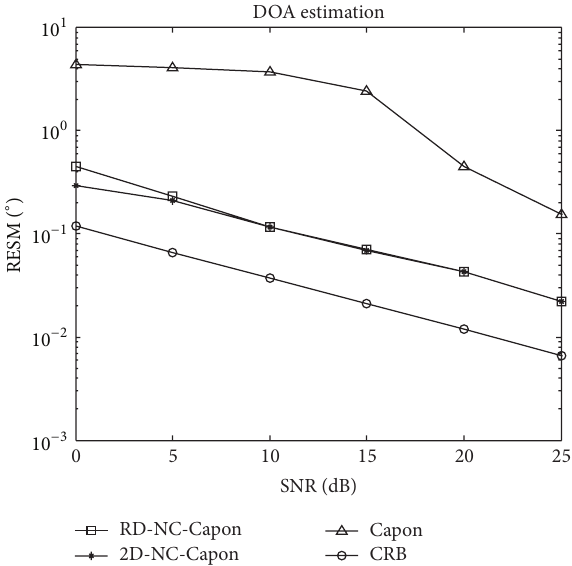
Figure 6: The DOA estimation performance comparison for non- uniform linear array ( 𝑀 = 8 , 𝐿 = 200 , and 𝐾 = 3 ).